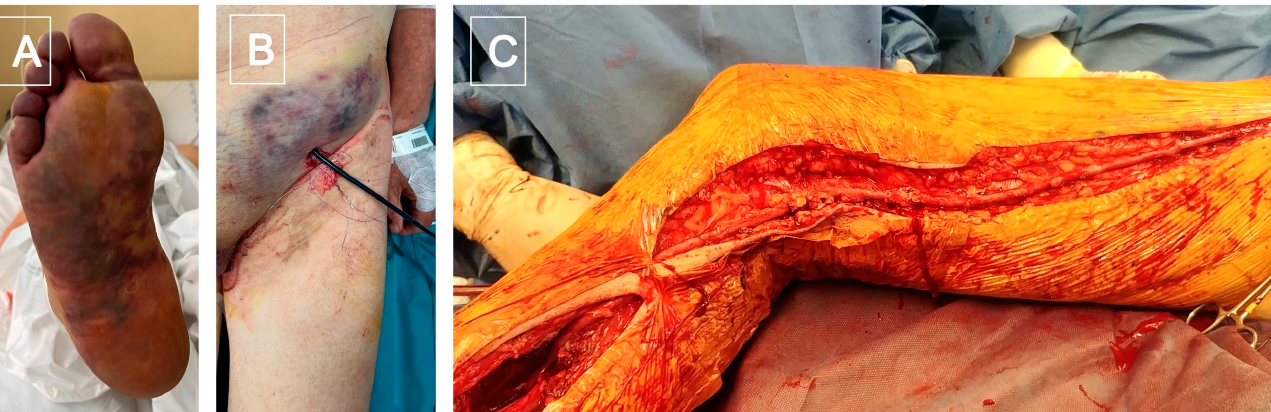
Figure 3. ( A ) Ischemic foot caused by a popliteal artery thrombosis; ( B ) failed temptation of catheter based local thromboaspiration; ( C ) femoro-tibioperoneal trunk by-pass, using an inverted great safenous vein.